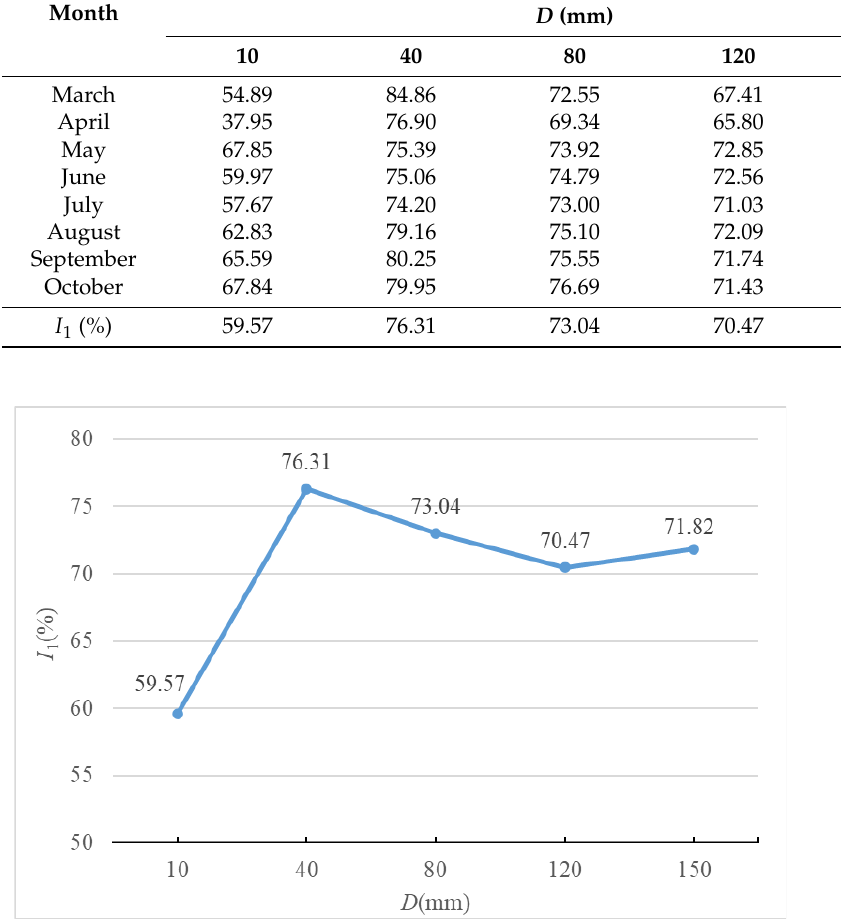
Figure 8. I 1 – D diagram for the evaporator test.